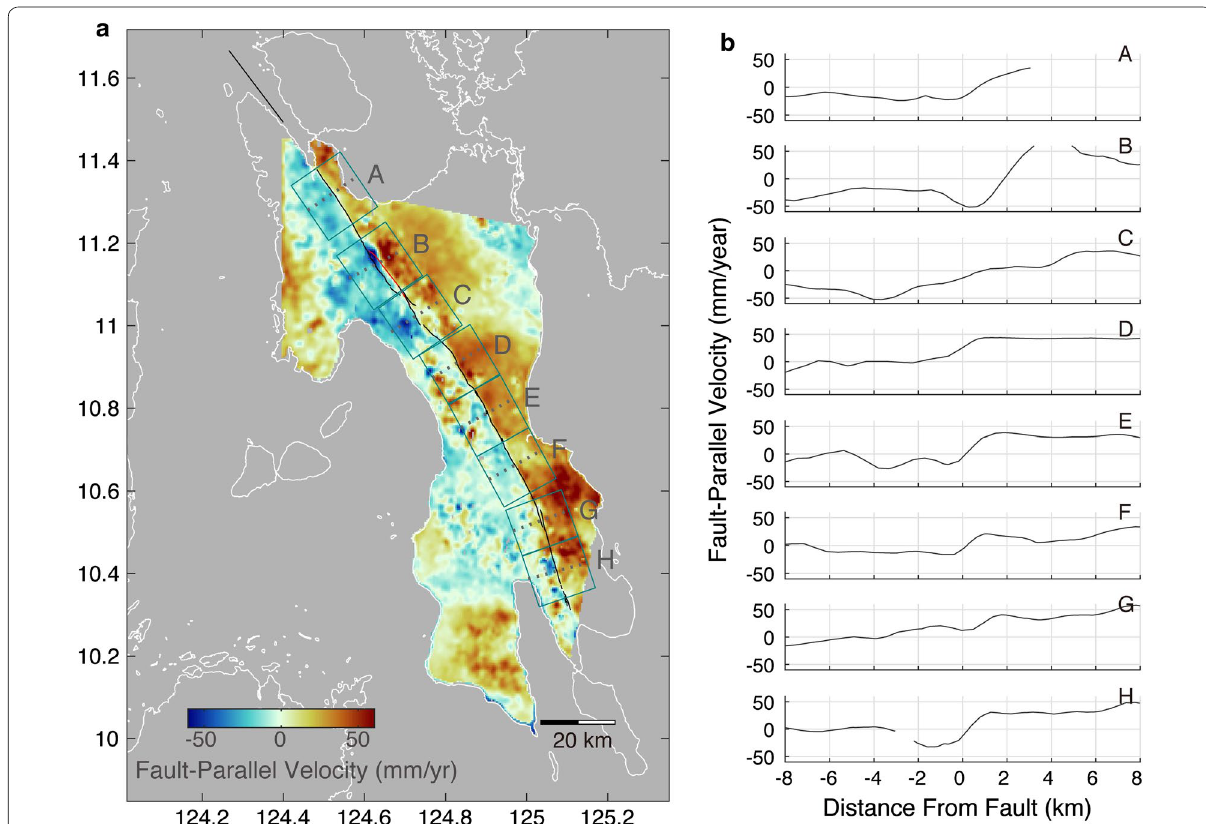
Fig. 6 a Mean velocity in the fault-parallel horizontal direction (N25 ◦ W). Direction N25 ◦ W is taken positive. b Velocity profiles along the lines shown in